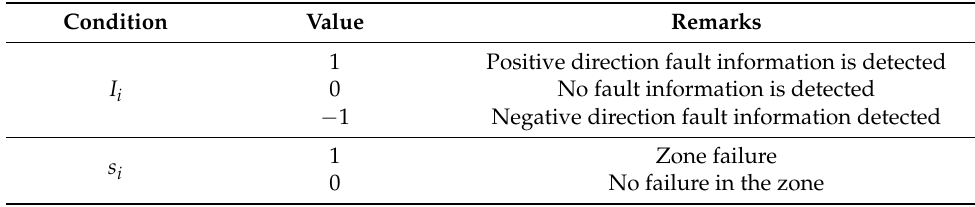
Table 2. Fault message coding